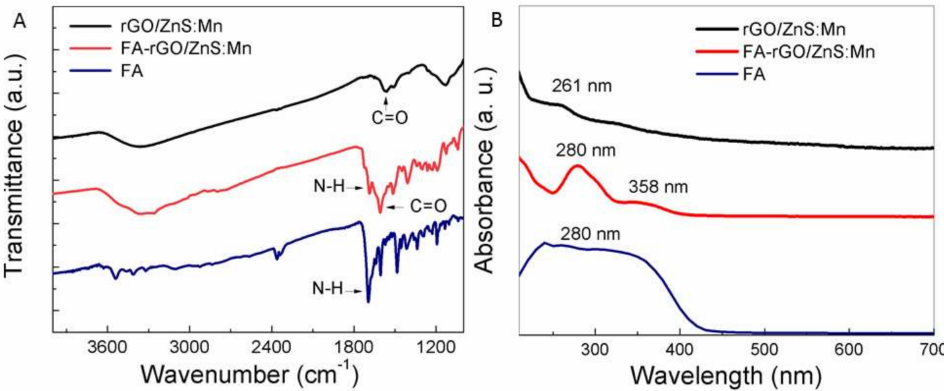
Figure 3. ( A ) FT-IR; and ( B ) UV-Vis spectra of rGO-ZnS:Mn, FA-rGO-ZnS:Mn and free folic acid (FA) showing the FA conjugation via carbodiimide covalent crosslinking